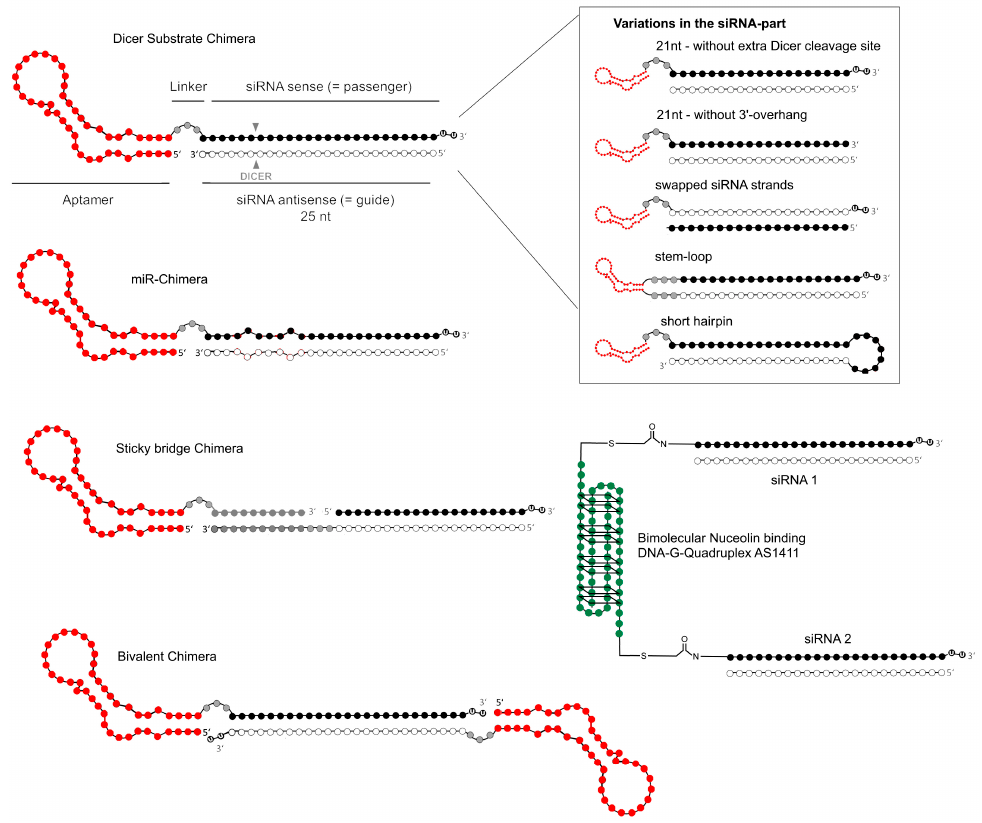
Figure 3. Aptamer-siRNA AsiC designs. Shown are different design strategies pursued. The Dicer-Substrate design as shown at the top, represents the most promising design for a universally functional combination of aptamer and siRNAs. The siRNA portion (21 nt) is appended through an extension of a 6 nt double strand, ensuring correct Dicer cleavage [47,62]. Adding a 2 nt 3 ′ -overhang to the sense strand and choosing this strand as the one connected to the aptamers 3 ′ -terminus is thought to lead to superior siRNA target knockdown. Other variations published (box on the right) comprise: A greater number of reported AsiCs, particularly in earlier studies, used 21 nt siRNAs lacking a Dicer substrate cleavage site [38]. Also tested were constructs lacking the 3 ′ -overhang, swapping the strands in the siRNA, or appending both siRNA strands to the aptamer-RNA, creating a stem-loop construct [39]. Wullner et al. reported a AsiC using a short hair-pin RNA (shRNA) design [41]. AsiCs with miRNAs implemented instead of an siRNA have also been reported [63–65]. A convenient way of testing multiple siRNA adapters on an aptamer and preserving the RNAi potential was presented by the sticky bridge design, in which aptamer and siRNA part are annealed through a reverse complementary pair of strands [66]. Constructs consisting of two aptamer units (bivalent AsiC) [41] or two siRNAs on the bimolecular nucleolin DNA-aptamer [60] have been shown to benefit from increased affinity or synergistic knockdown effects, respectively.